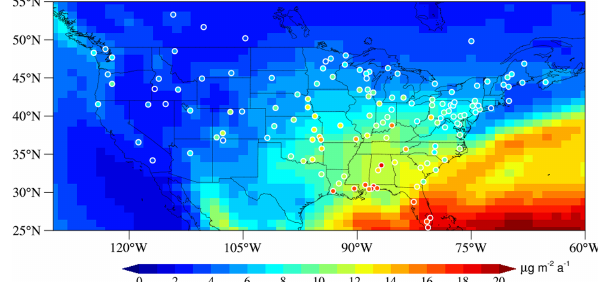
Figure 7. Comparison between modeled (background) and ob- served (circles) annual Hg II wet deposition fluxes over North Amer- ica for 2011–2013. Annual observations are derived from the Mer- tion Program, http://nadp.slh.wisc.edu/MDN/, last access: 19